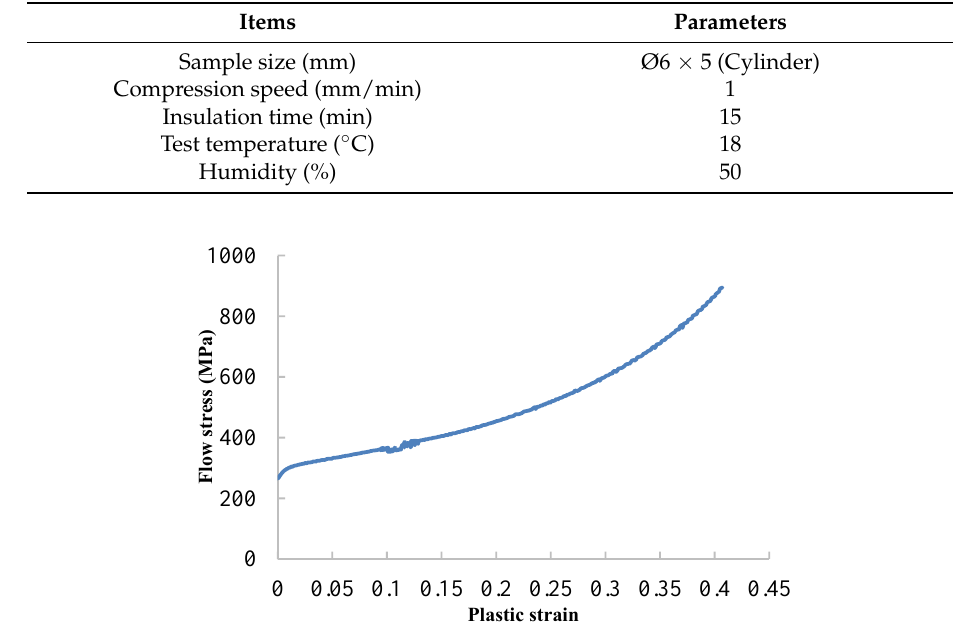
Figure 5. Flow stress ‐ plastic strain curves.